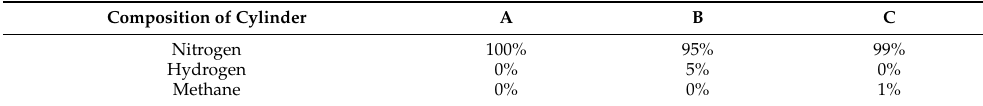
Table 1. Calibration gas mixtures with different amounts of nitrogen, hydrogen, and methane.